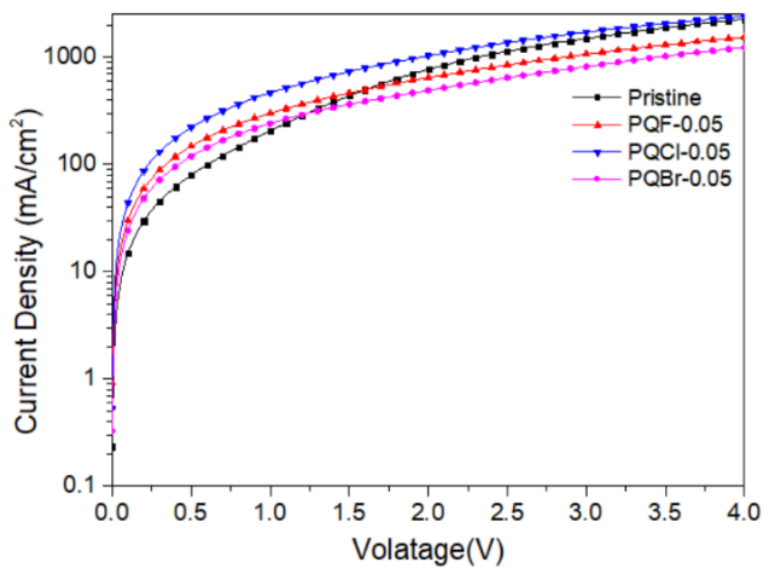
Figure 14. Current density–voltage plots of the hole-only devices FTO/NiO x /cellulose derivative/MAPbI 3